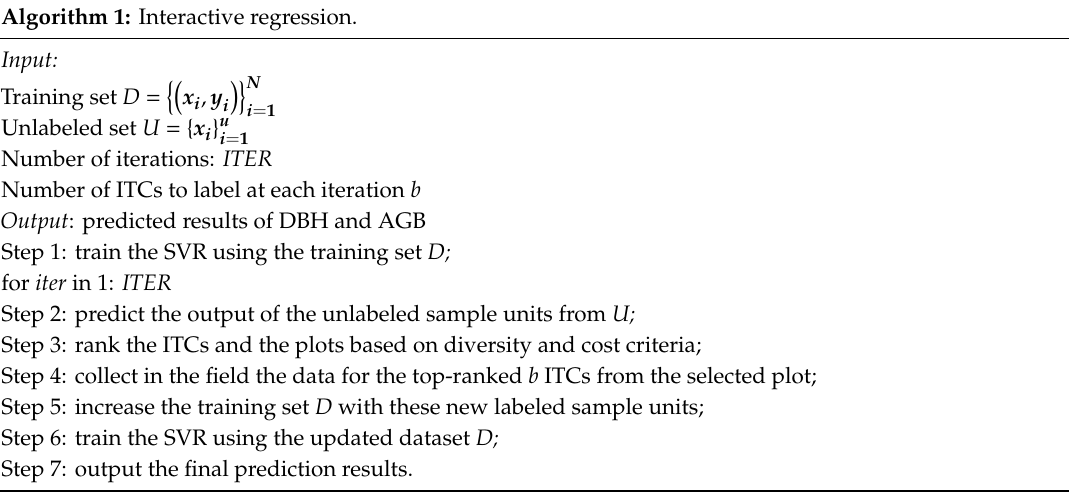
Figure 3. Block diagram of the proposed interactive regression method.